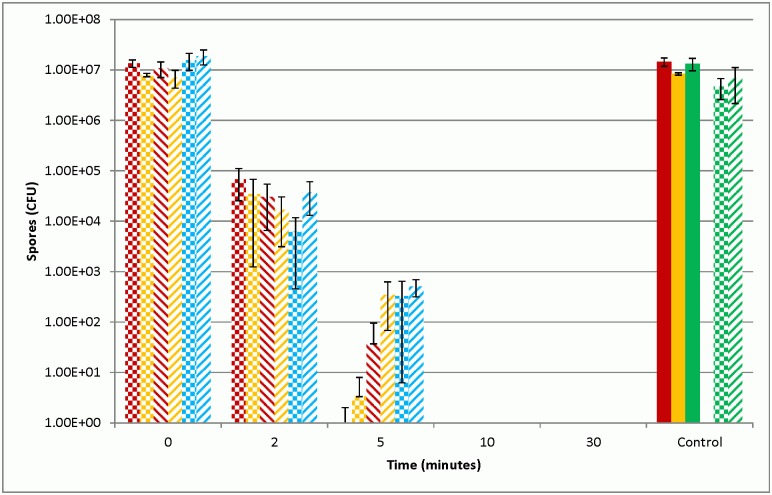
Recovery of B. anthracis spores after exposure to decontaminants.Recovery of B. anthracis Sterne spores (Red) or Ames spores (Yellow) after exposure to test decontaminants over specified periods of time. Sterne spores were quenched using DE broth (blue) after exposure to the decontaminants. Untreated controls (solid bars), chlorine dioxide based test decontaminant (checker bars), 0.5% sodium hypochlorite (striped bars). Quench control samples (Green) were DE broths incubated with each decontaminant prior to Sterne spore addition or in DE broth alone (solid bar). Data are presented as means (n = 3) CFU ml-1 of spores recovered after specified contact times with decontaminants.